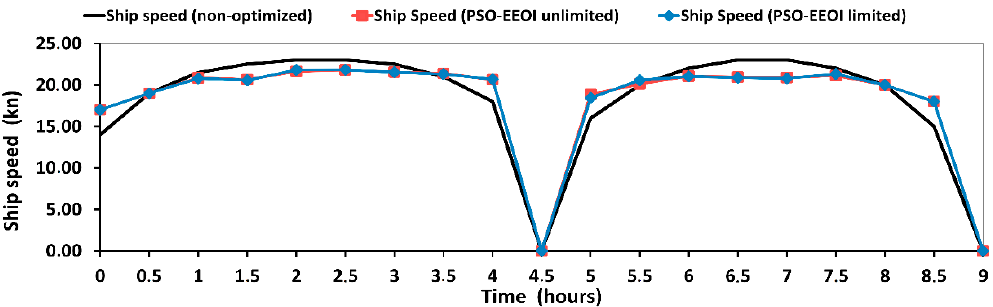
Figure 10. Ship speed (kn): PSO with/without EEOI limitation.